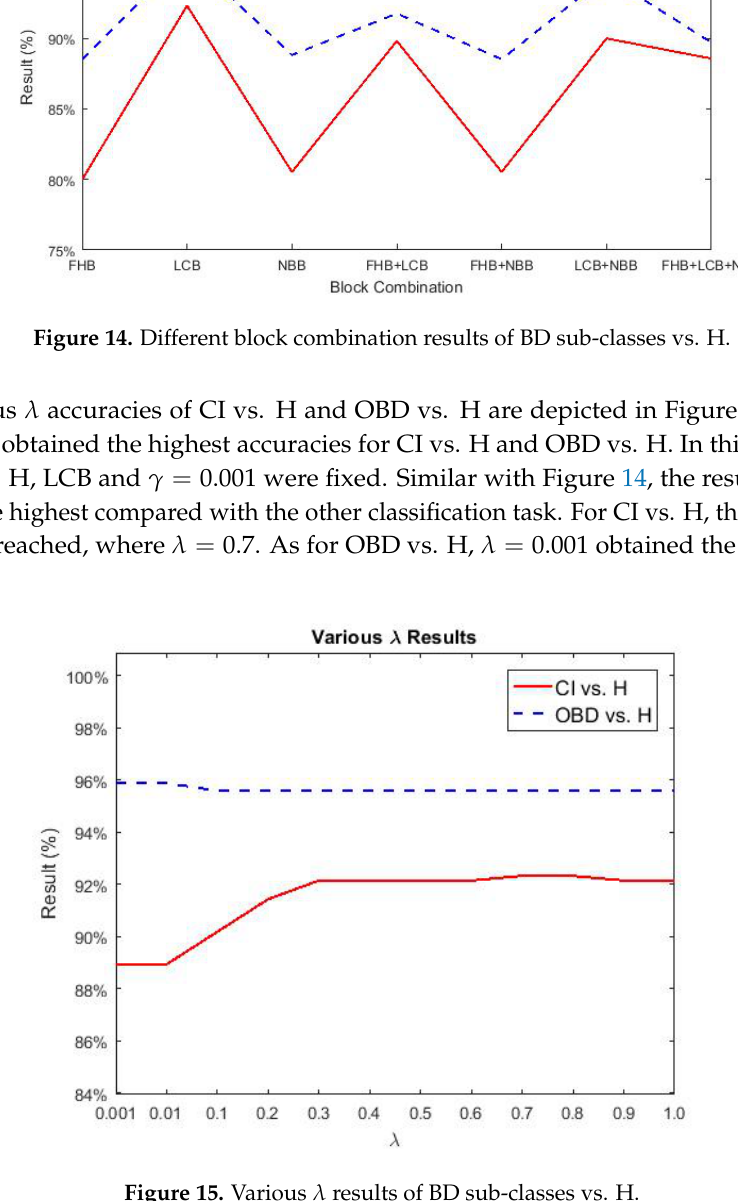
Figure 15. Various λ results of BD sub-classes vs.